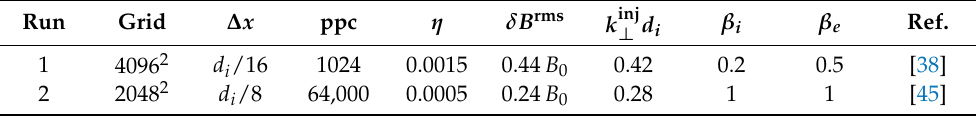
Table 1. List of simulations and their relevant numerical and physical parameters. From left to right, we report the number of points of the 2D box, the spatial resolution, ∆ x , the number of particles-per- cell, ppc, the resistivity, η , the rms amplitude of the initial magnetic fluctuations, B rms , the injection scale, k inj ⊥ , the ion plasma beta, β i , and the electron plasma beta, β e . Finally, we list the corresponding references where the two simulations were first presented, which contain complementary information and